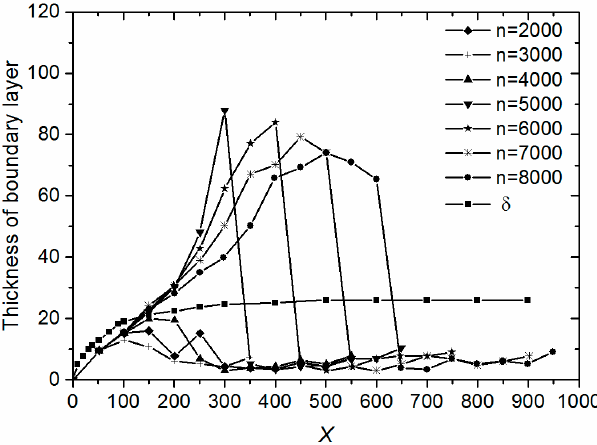
Figure 11. Thickness of the boundary layer of double cylinders at different n .